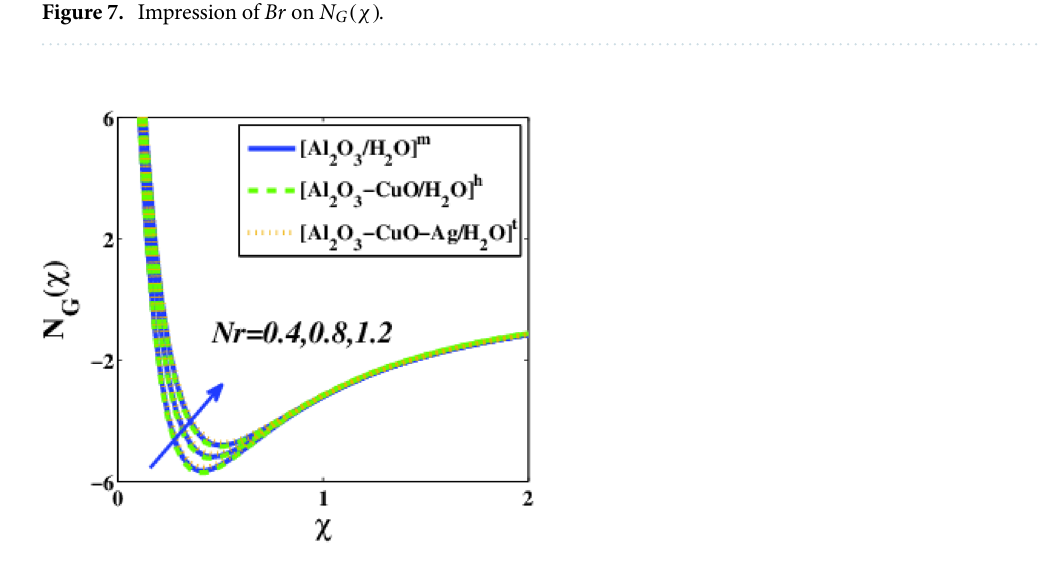
Figure 8. Control of Nr on N G (χ)